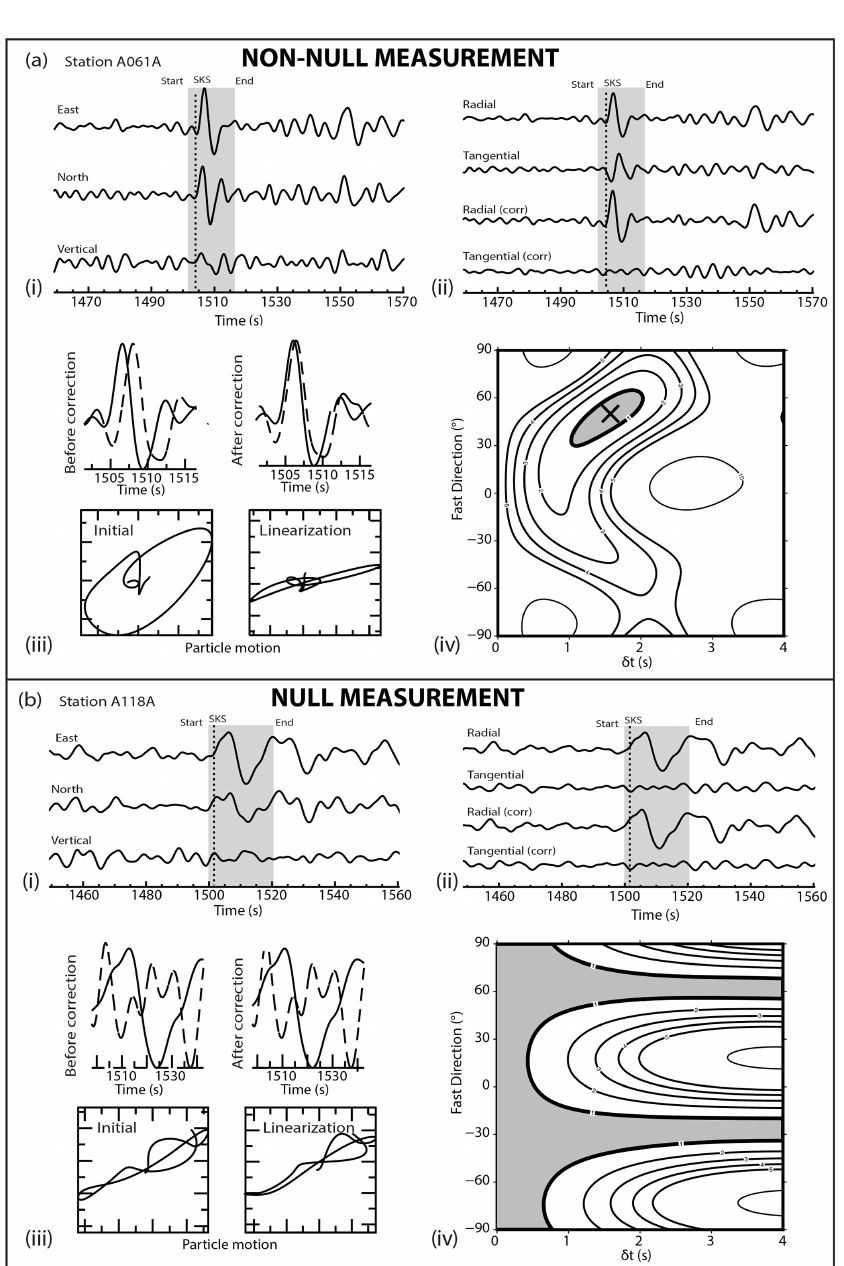
Figure 3. Examples of SKS analysis procedure for a successful SKS splitting measurement (a) and a situation where no energy is present on the tangential component, referred to as a null measurement (b) . (i) Three-component seismograms recorded at station A061A, with the time window including SKS phase highlighted. (ii) The radial and tangential component seismograms, after rotation to the great circle arc (top two) and after the SKS splitting correction (bottom two). (iii) Top: time windows of the radial (black line) and tangential (dashed line) components showing the SKS phase before and after the correction. Bottom: particle motion before and after correction. (iv) Misfit contour surface showing the best solution pair of δt and ϕ (cross) and the 1 σ uncertainty surface (highlighted